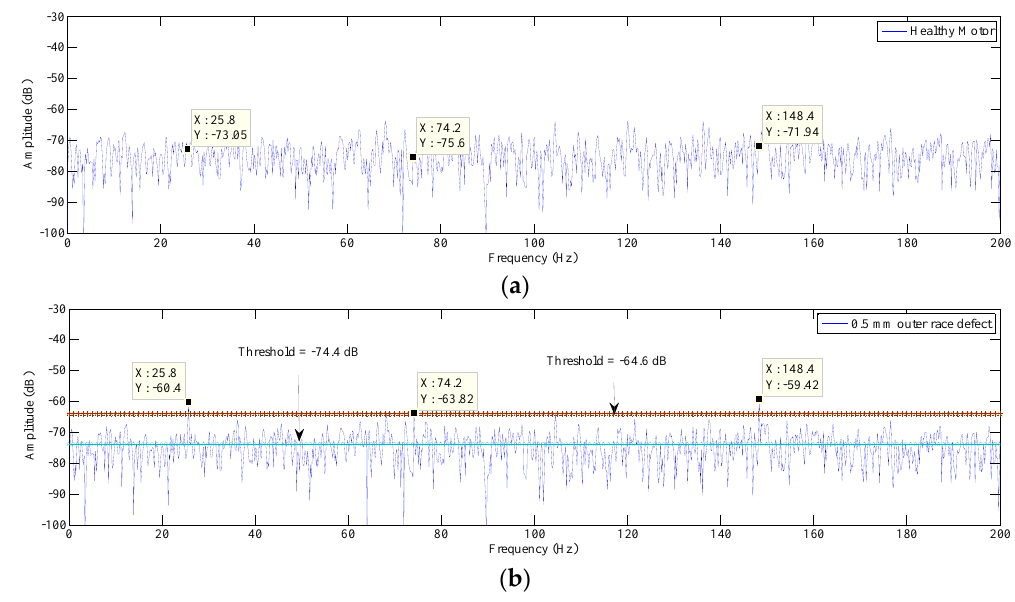
Figure 8. The PV modulus spectrum of the motor under full-load condition at bearing fault frequencies of 25.8 Hz, 74.2 Hz and 148.4 Hz ( a ) Healthy bearing ( b ) Defected bearing.